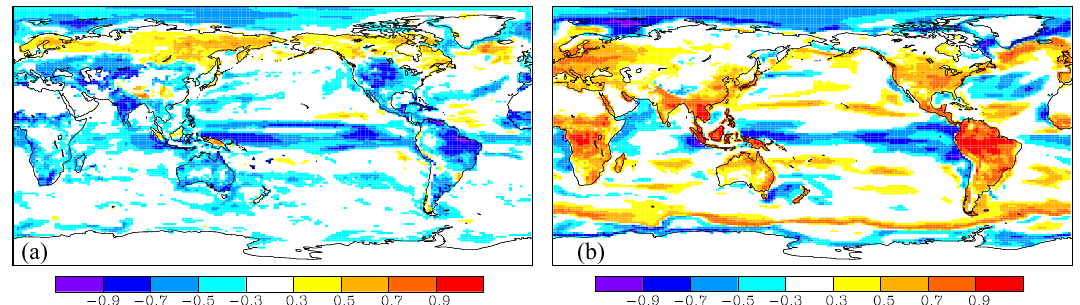
Figure 13. Correlation between annual carbon flux to the atmosphere and (a) annual mean precipitation and (b) annual mean screen-level temperature for years 901–1000 from the ProgLAI simulation.